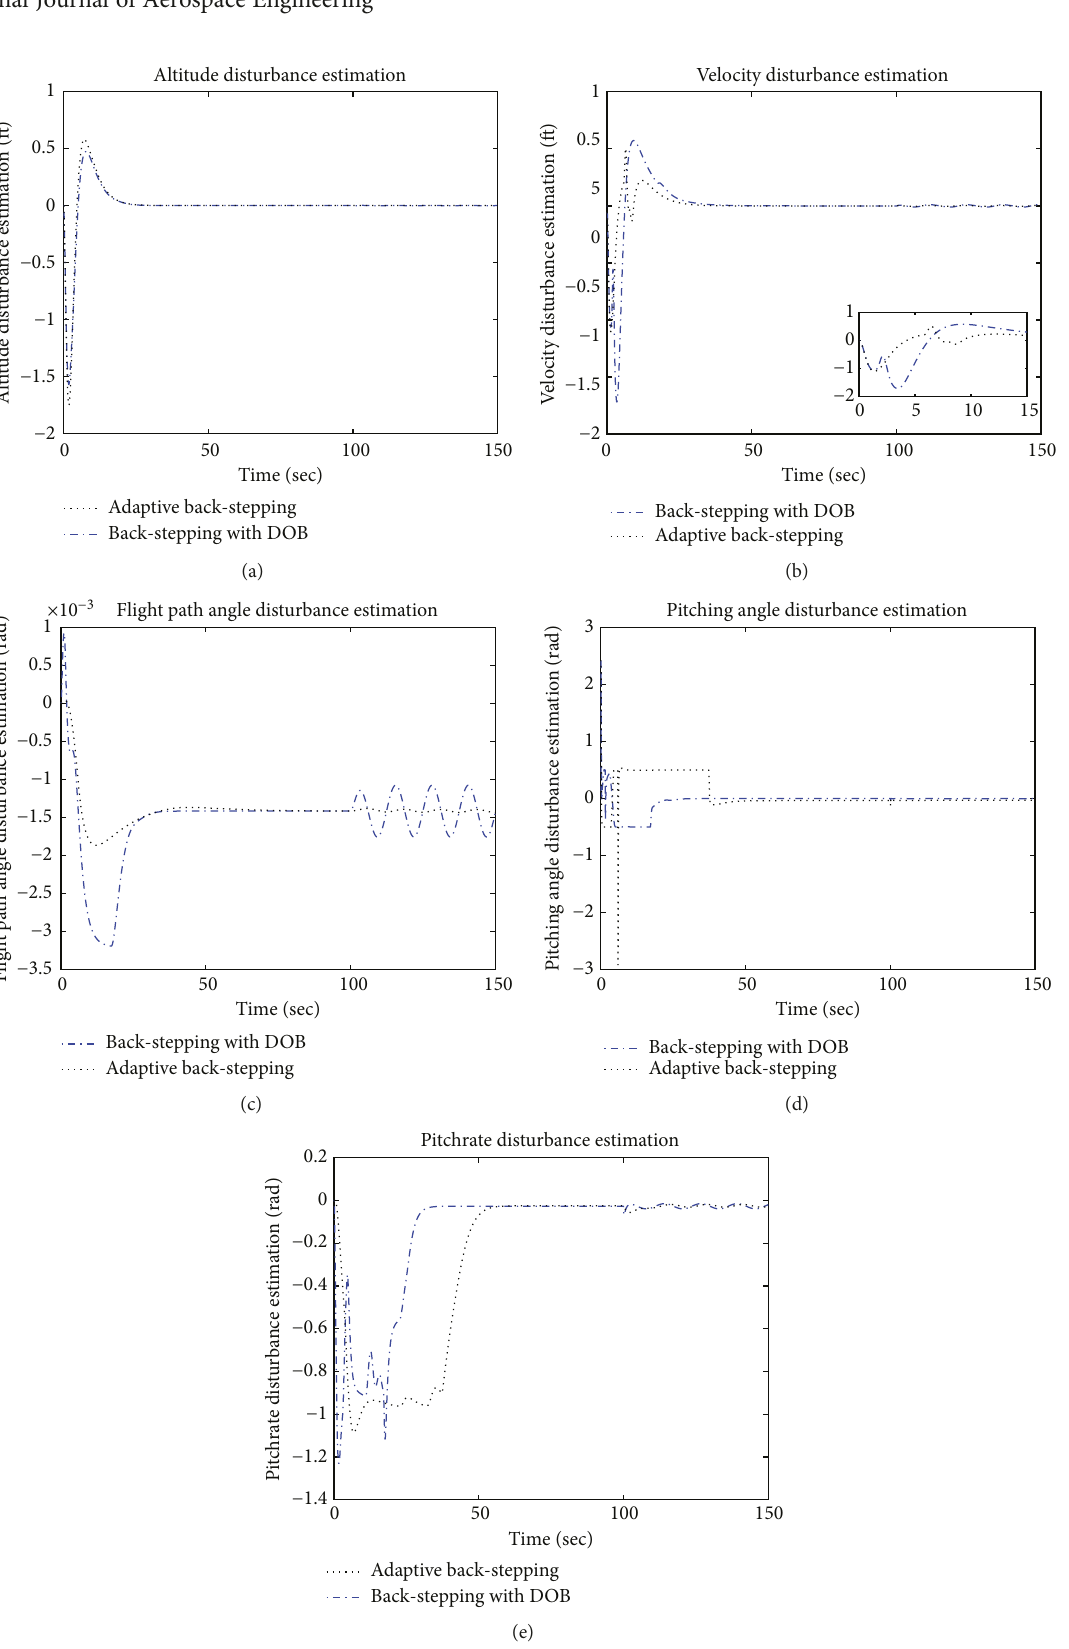
Figure 4: Lumped disturbances estimated by